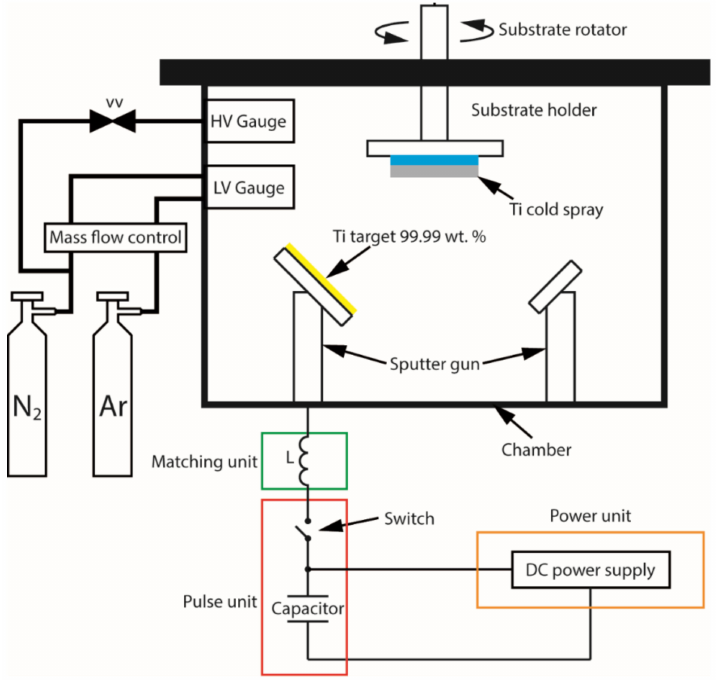
Figure 3. Schematic of the HiPIMS